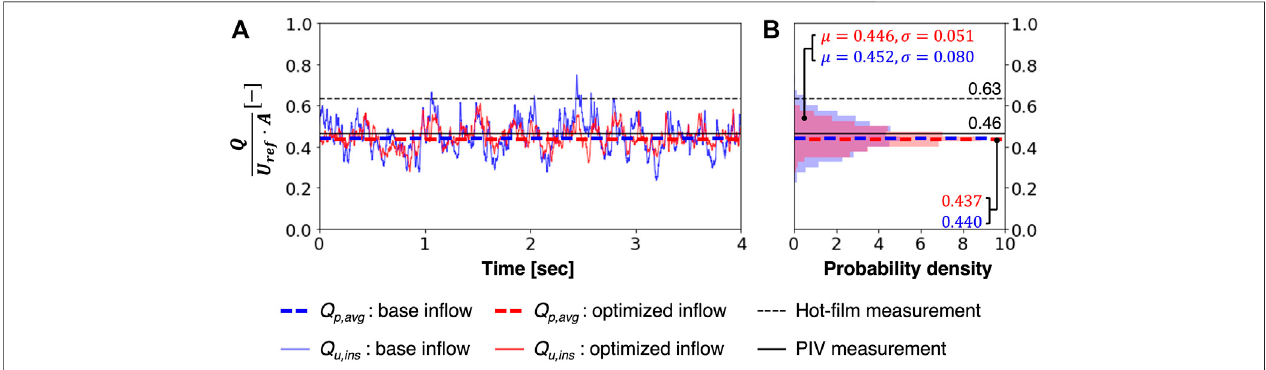
FIGURE 11 | In fl ow sensitivity study results for the dimensional ventilation rates: (A) Time series of ventilation rate calculated from the velocity fi eld, together with average ventilation rate estimated from the time-averaged pressure fi eld, and the experimental values; (B) Corresponding distributions and mean values.